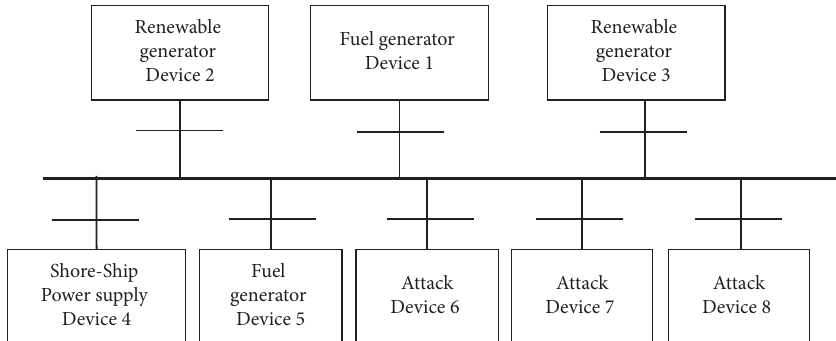
Figure 2: Port power system configuration.